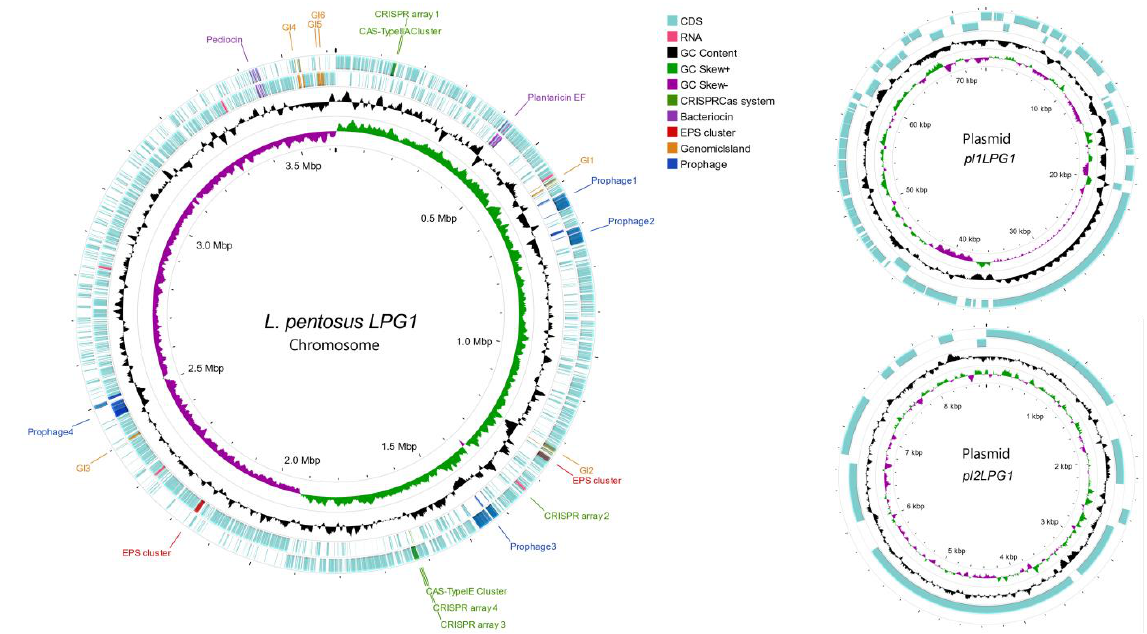
Figure 1. Chromosome and plasmid visualization of the LPG1 genome. The outermost and the second ring illustrate the CDS and important markers (labels) in the forward strand and reverse strand respectively; the third circle (black) presents the GC content, the following ring denotes the GC skew index, and the last innermost ring displays the genome size.